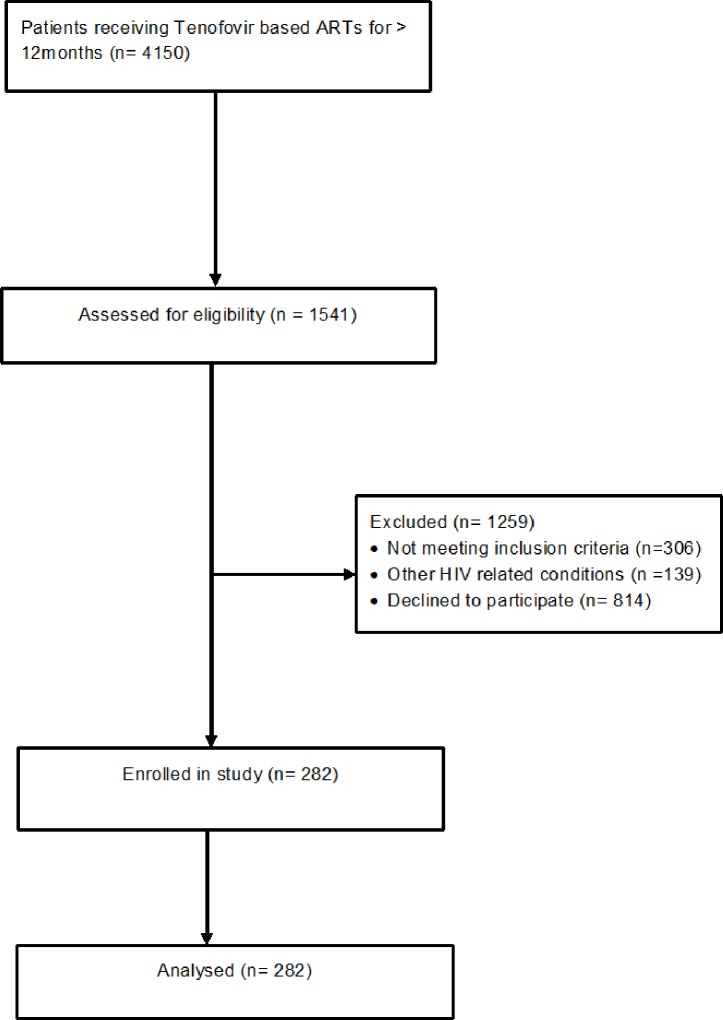
Study flow diagram.